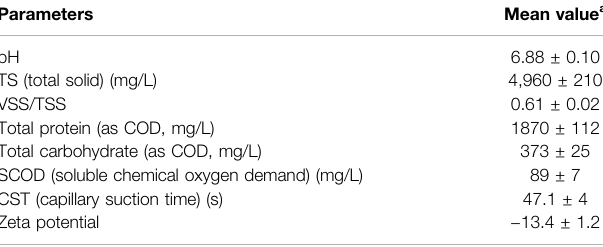
TABLE 1 | Physical and chemical properties of raw sludge.